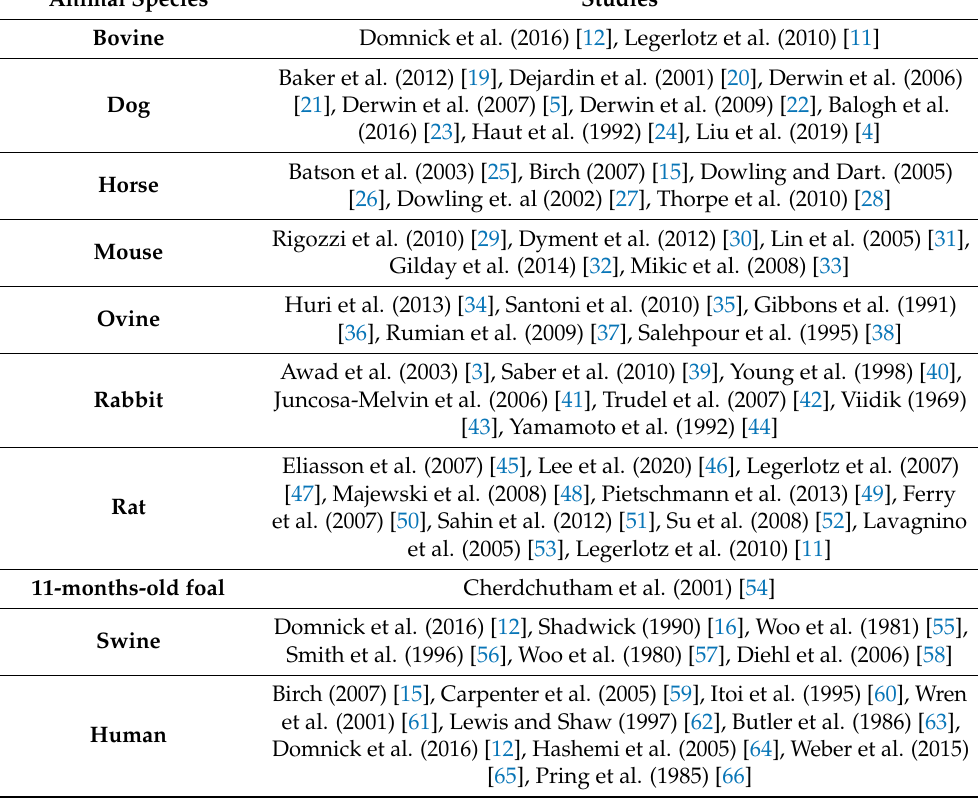
Table 1. All the selected articles, organized by